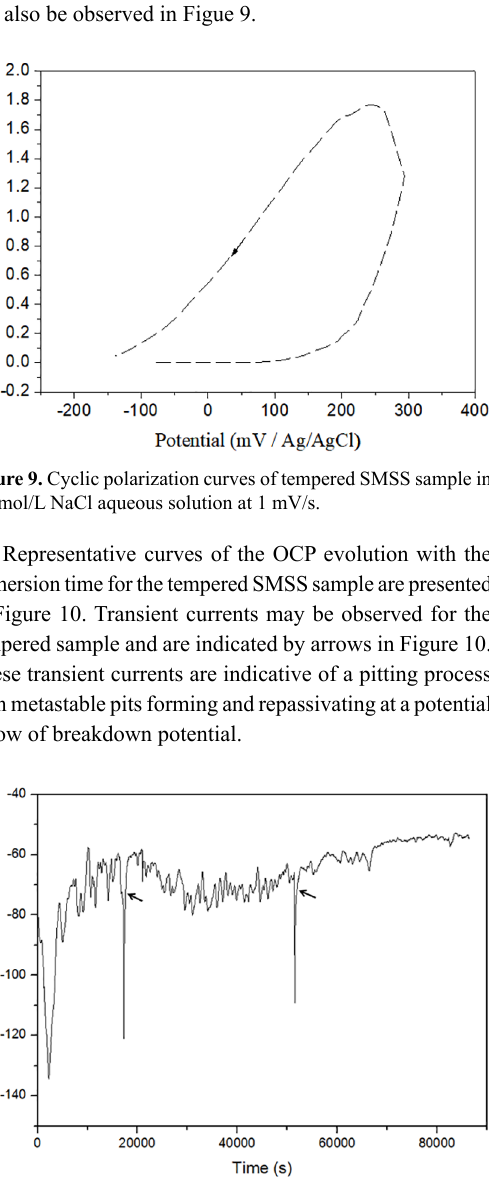
Figure 10. OCP of tempered SMSS sample acquired during 86400s in 0.1 mol/L NaCl aqueous solution.